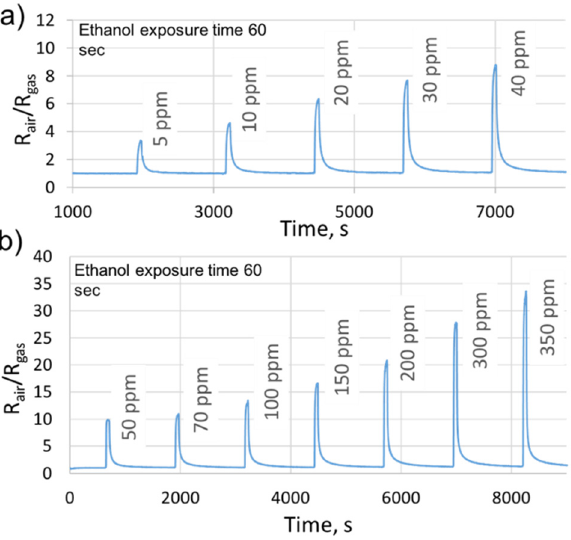
Figure 9 . The gas sensor responses for ( a ) low and ( b ) high ethanol concentrations, under dry air, at the sensor’s optimal working temperature.